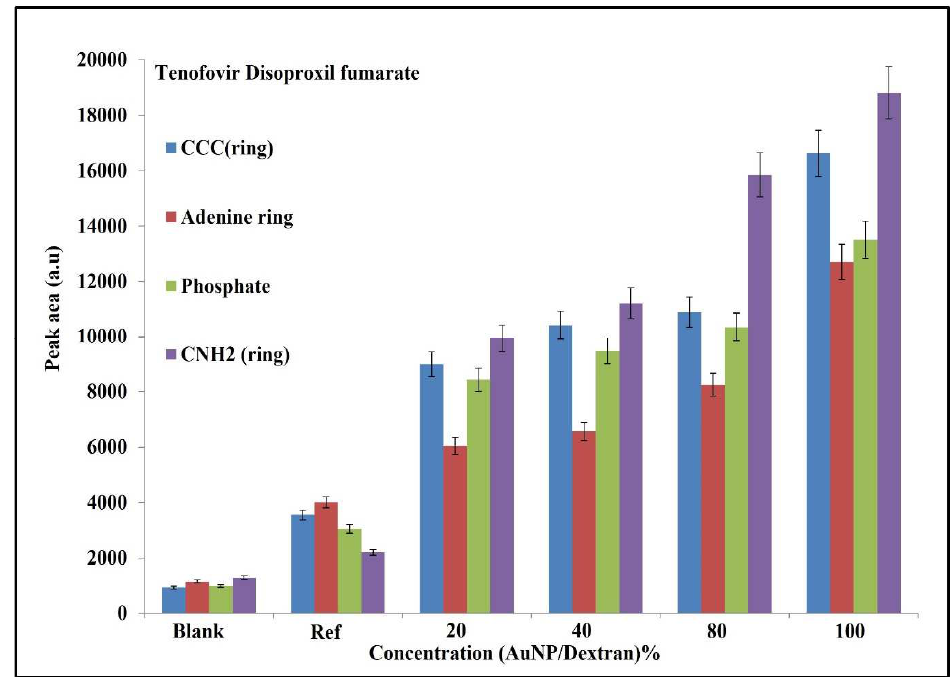
Figure 7. Histogram of tenofovir functional groups. The plot shows a peak area (PA) vs. AuNP/dex- tran concentration. The blank sample is 5% dextran, while the reference is 20% tenofovir in 5% AuNP/dextran solution; 5% error bars are shown for each analysis.